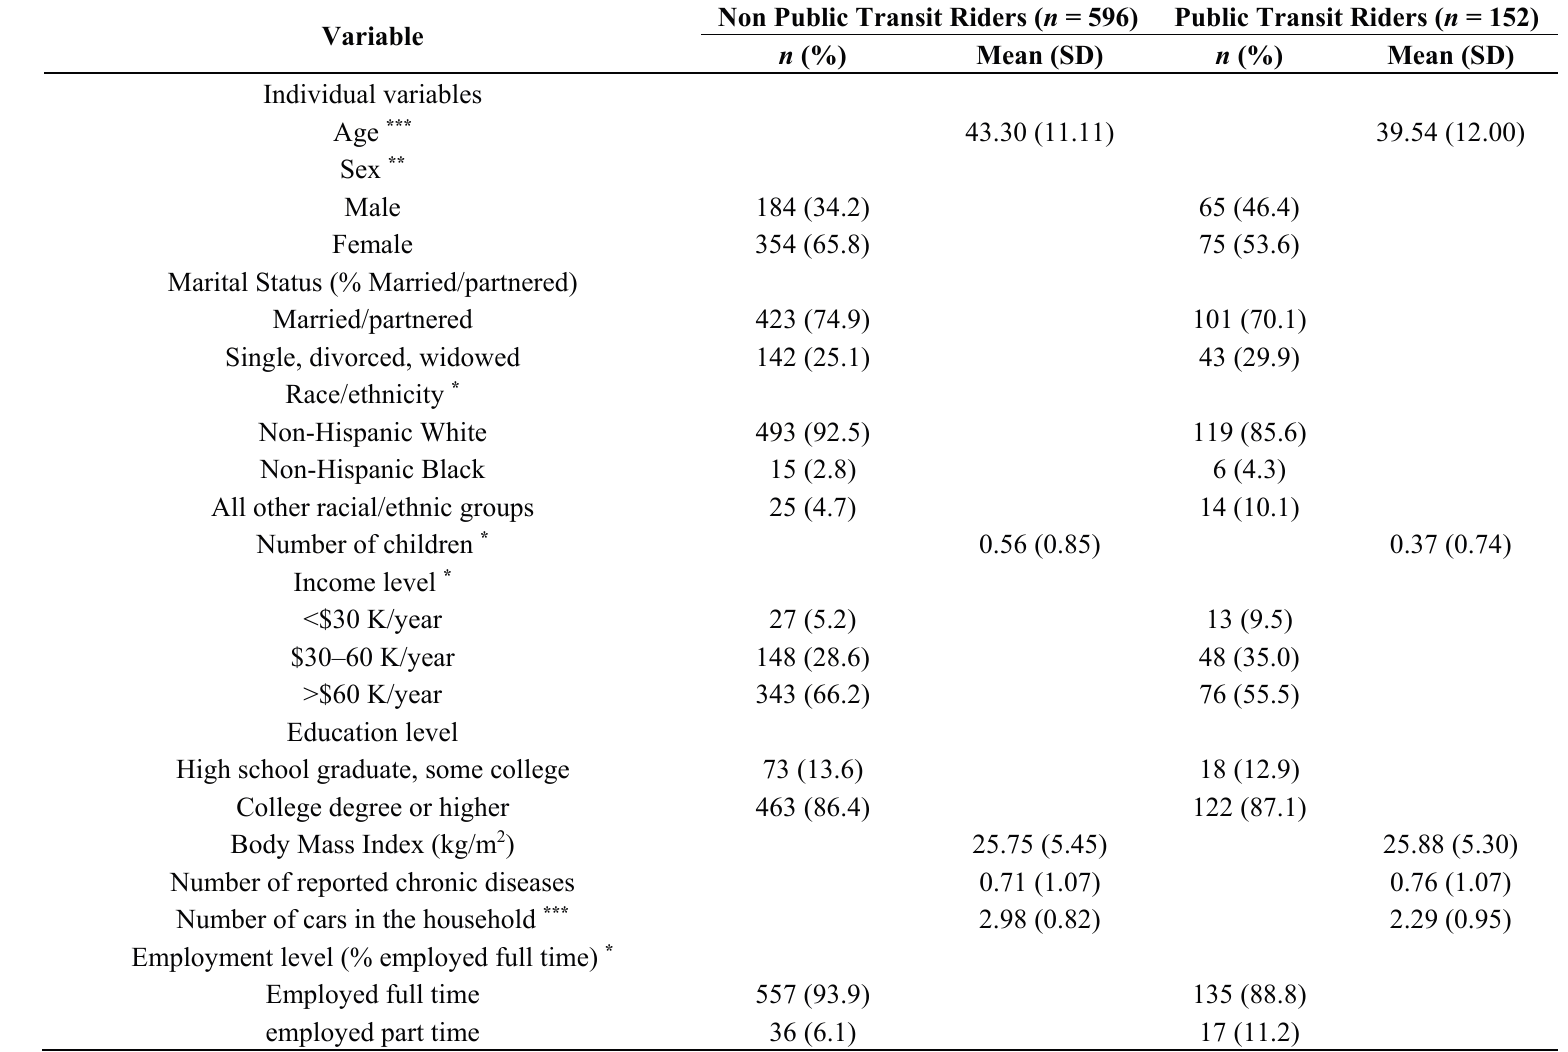
Table 1. Characteristics of the Sample ( n =